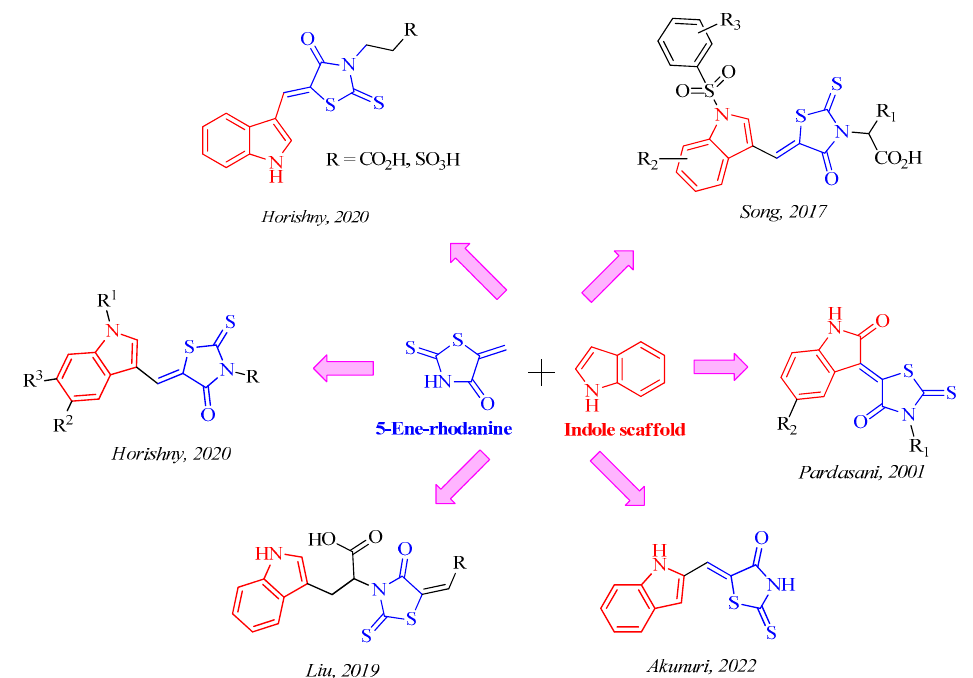
Figure 3. Antimicrobial agents containing indole and rhodanine ring.